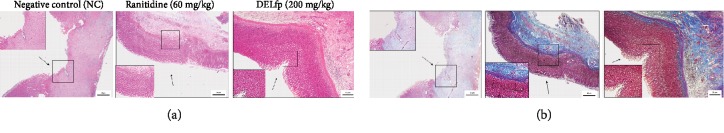
Photomicrographs of the gastric mucosa stained with hematoxylin/eosin (a) and Masson's trichrome (b) of rats submitted to induction of chronic ulcer by 30% acetic acid. The animals were treated orally with 0.9% NaCl solution (negative control, NC), ranitidine (60 mg/kg), or dry extract of L. ferrea pods (DELfp, 200 mg/kg) for 14 days. The filled arrow indicates the absence of ulcer and/or preserved columnar simple epithelium or reepithelialisation, and the dashed arrow indicates the presence of ulcer, lymphoplasmacytic infiltrate, and destruction of the mucosa.